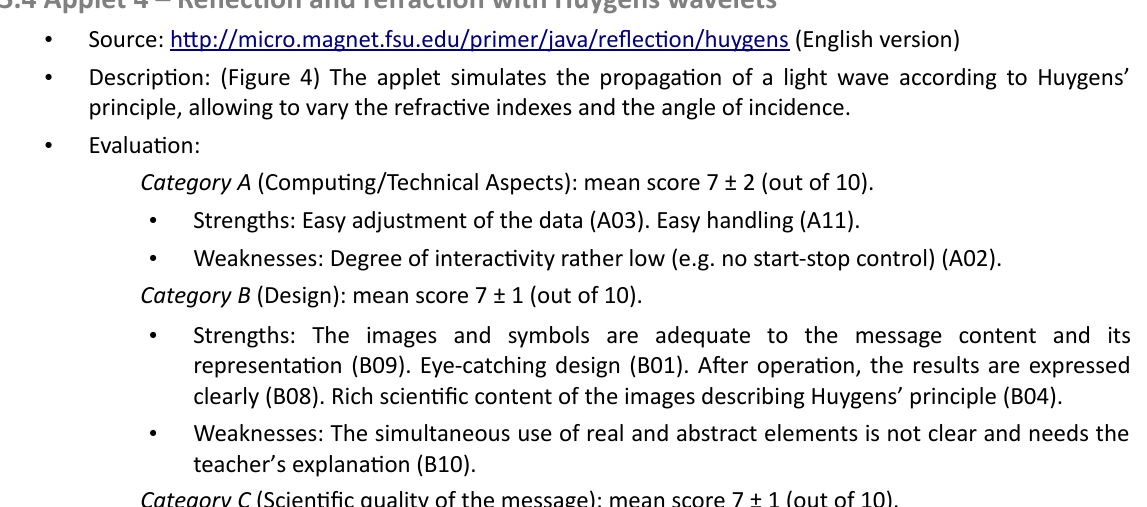
Description: (Figure 4) The applet simulates the propagation of a light wave according to Huygens’ principle, allowing to vary the refractive indexes and the angle of